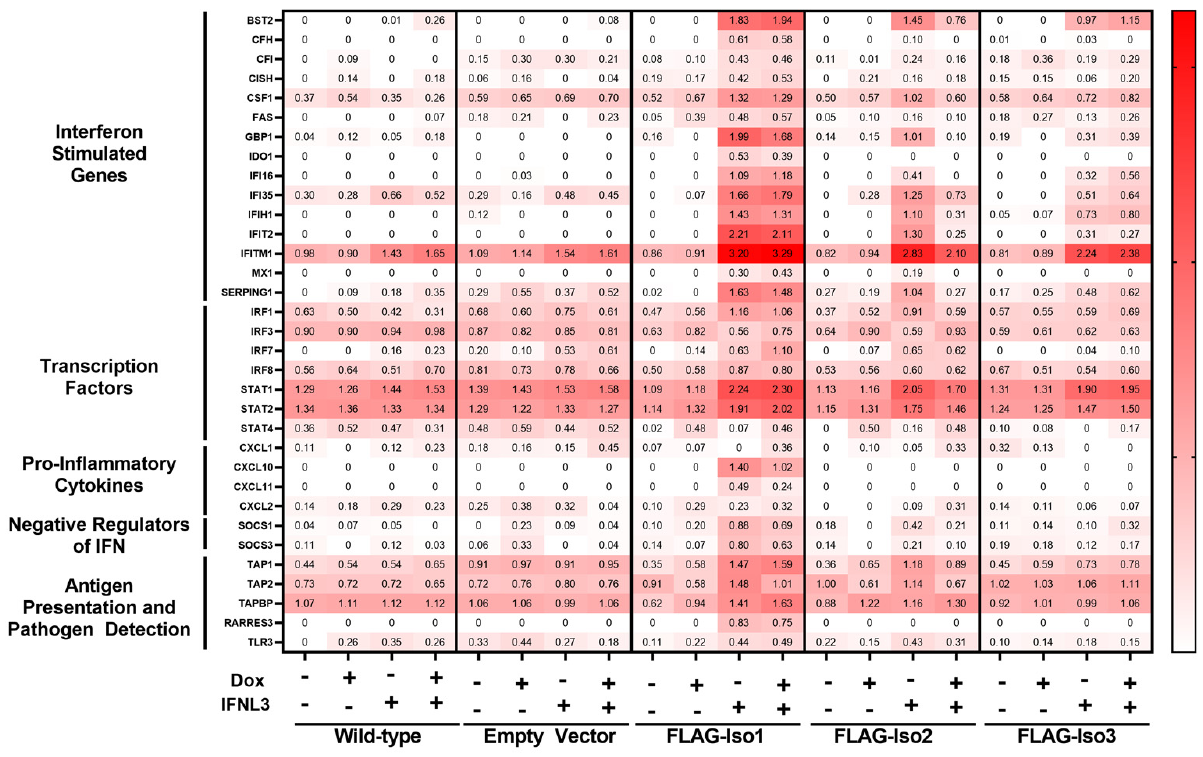
Figure 8. Relative expression of FLAG-IFNLR1 isoforms differentially influences IFNL3-dependent gene expression. HEK293T WT and stable lines were induced ± dox (100 ng/mL) for 24 h prior to treatment ± IFNL3 (100 ng/mL) for an additional 24 h. RNA was collected and gene counts were quantitated using NanoString analysis (nCounter Human Immunology v2 Panel). Data are shown as log transformed normalized counts of differentially expressed genes (>2-fold change in any con- dition).